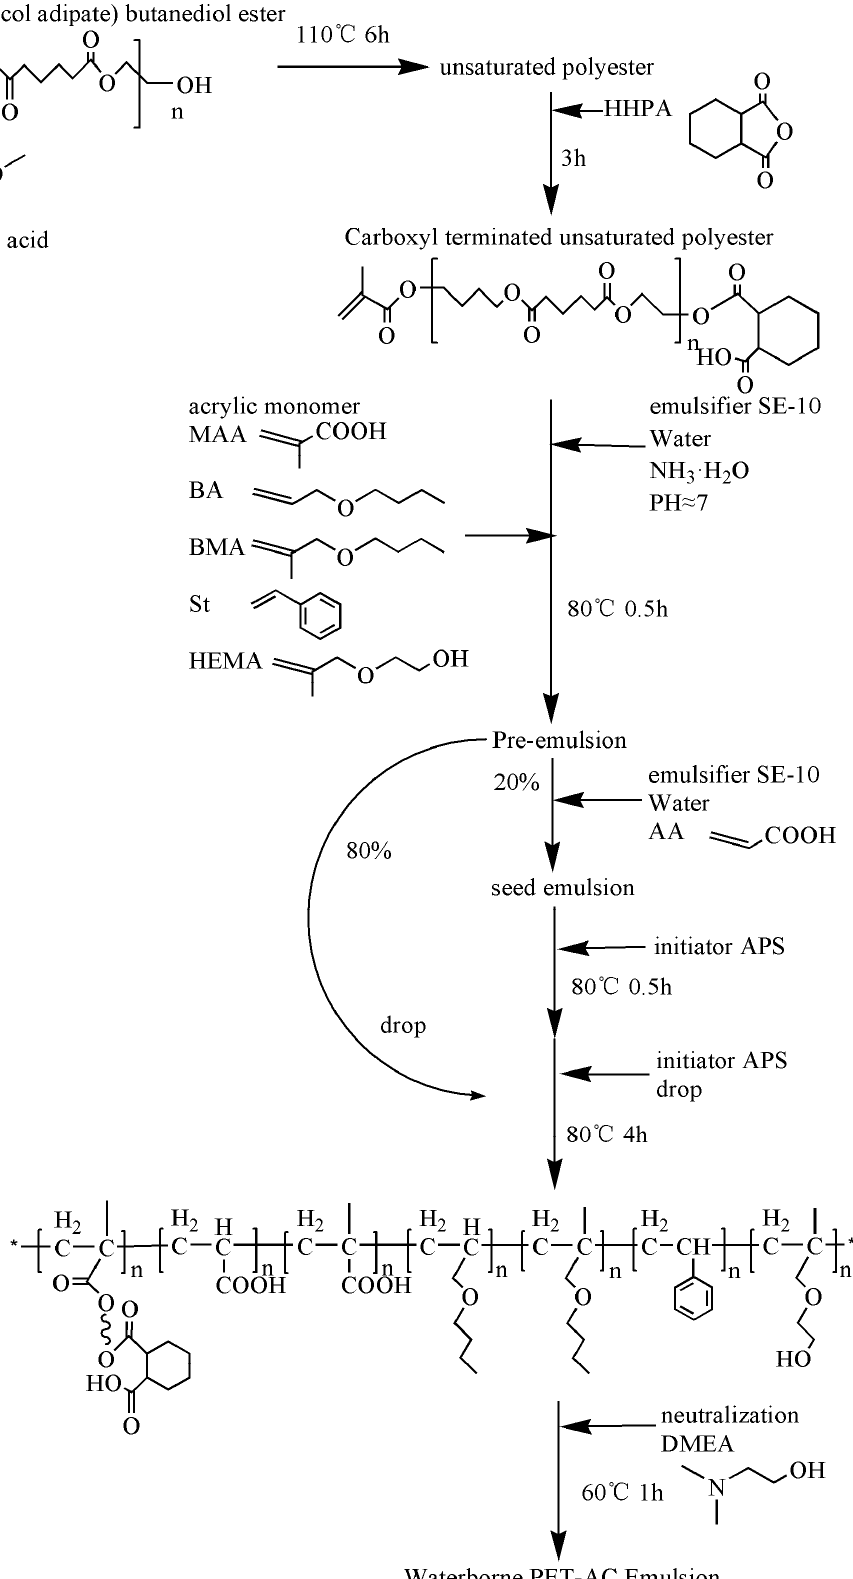
Figure 1. Synthetic route of waterborne PET-AC emulsion.